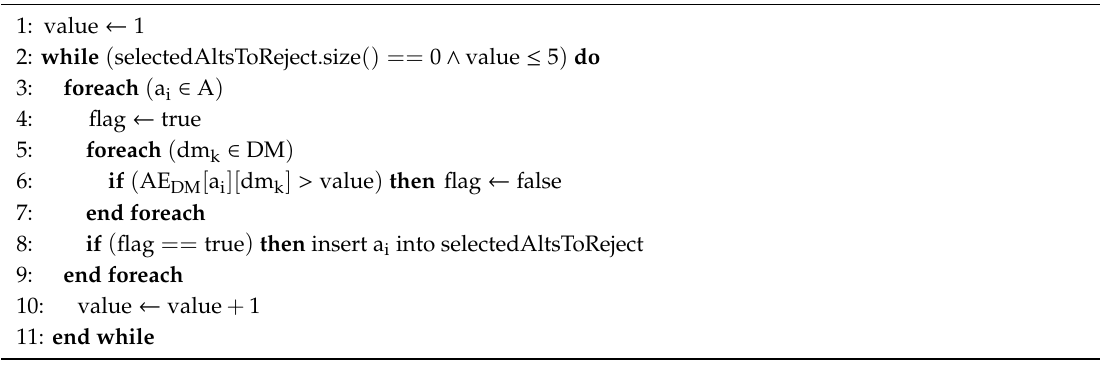
Algorithm 2. Algorithm for selecting the alternatives candidate to